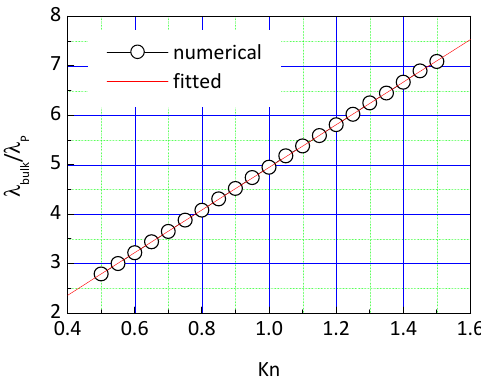
Figure 3. Comparison between fitted conductivity of primary particle chains and numerical data.